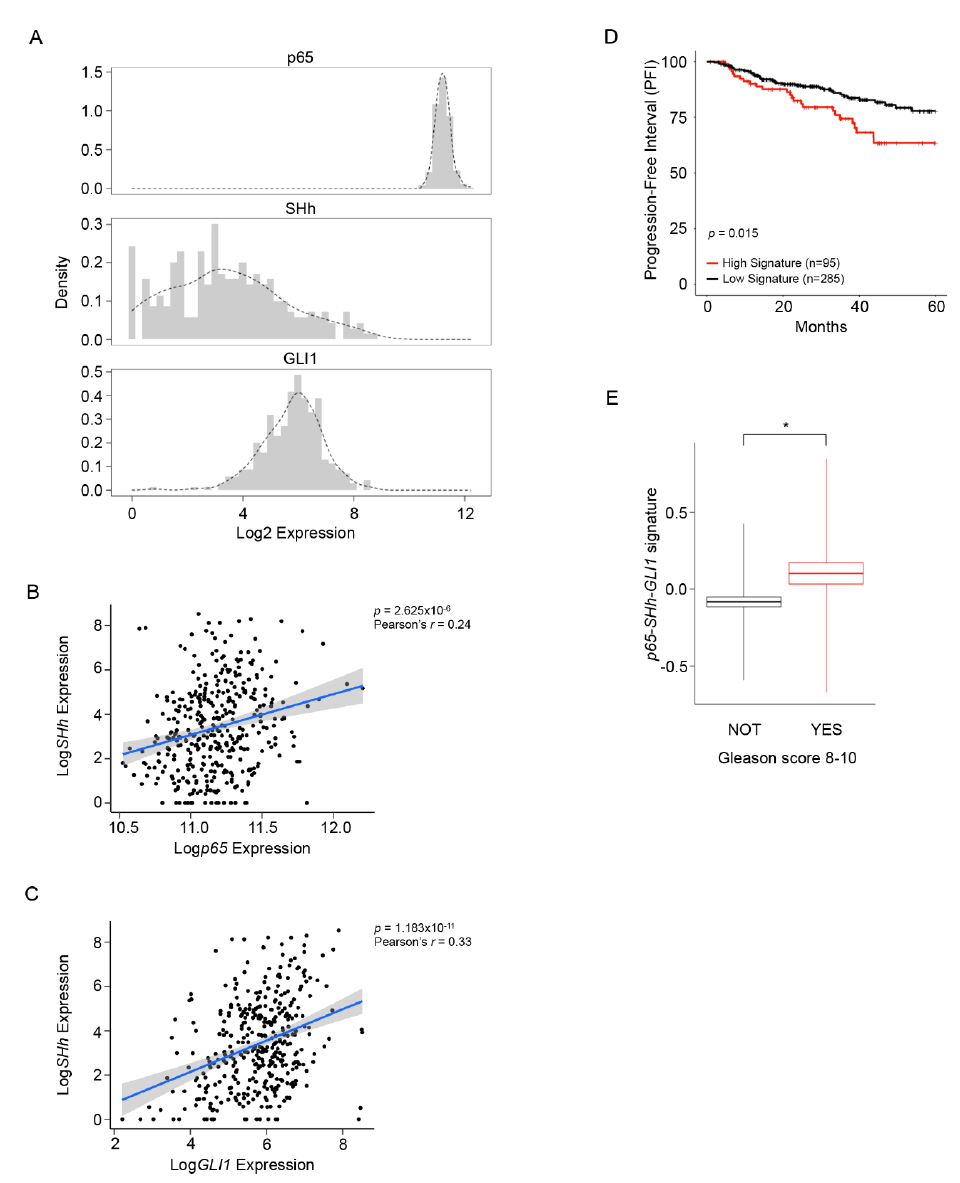
Figure 1. The correlation between the NF- κB -SHh-GLI1 axis and poor clinical outcome in PCa. ( A ) Histogram and sample density (dotted line) plots of p65 , SHh and GLI1 expression levels in patients with prostate adenocarcinoma from the TCGA dataset ( n = 380). ( B , C ) Shown are the correlations between p65 and SHh mRNA expression ( B ) and GLI1 and SHh mRNA expression ( C ) in patients from ( A ). Pearson’s correlation values and p -values are shown. ( D ) Progression Free Interval (PFI) curves in patients from ( A ) stratified based on tumor-associated p65-SHh-GLI1 signature expression using the 75th percentile as a stratification threshold. ( E ) Box plots showing the expression levels of the p65-SHh-GLI1 signature in patients with a Gleason score <8 (black, n = 252) and ≥ 8 (red, n = 128) from ( A ). Shown in the box plots are the mean (horizontal lines), mean ± SEM (box outlines), or mean ± SD (vertical lines). Statistical significance was calculated by the 2-tailed Student’s t -test. * p <